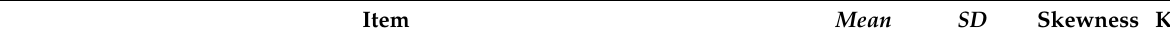
Table A6. Descriptive analysis of the New Ecological Paradigm ( n = 605, 2019 sample).